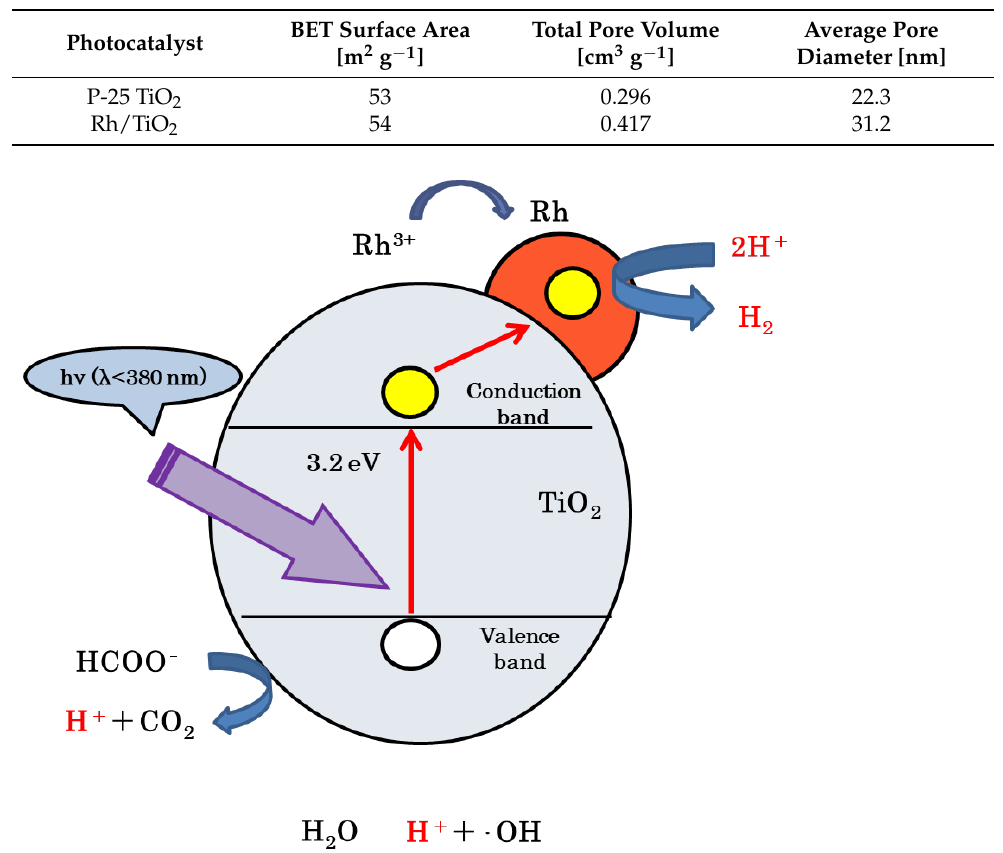
Table 1. Physicochemical properties of TiO 2 and Rh/TiO 2 .